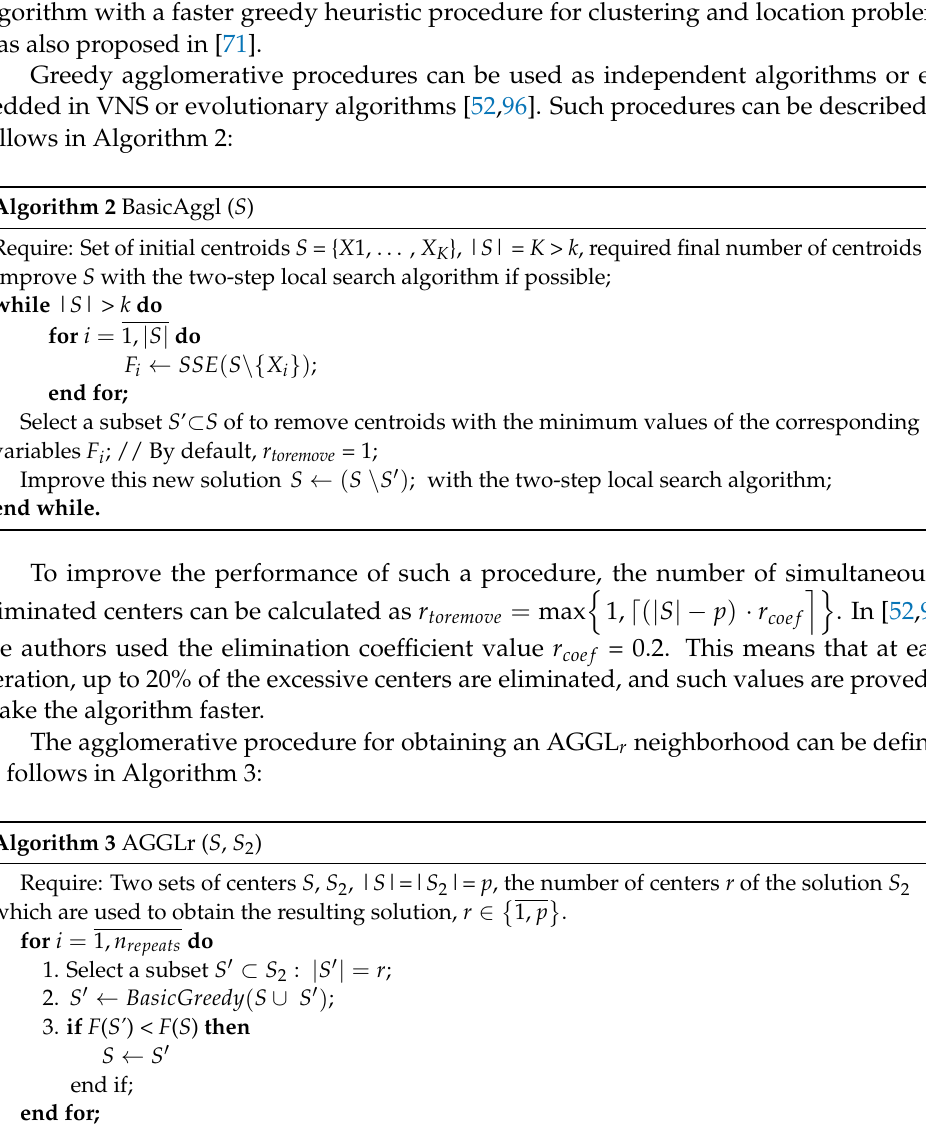
algorithm with a faster greedy heuristic procedure for clustering and location